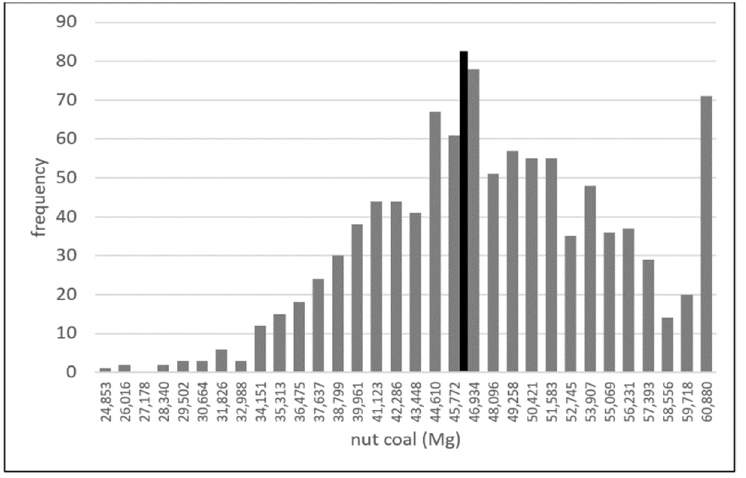
Figure 8. Histogram showing frequencies of achieving given quantity of sales of coal for mine “F” with σ yprog .